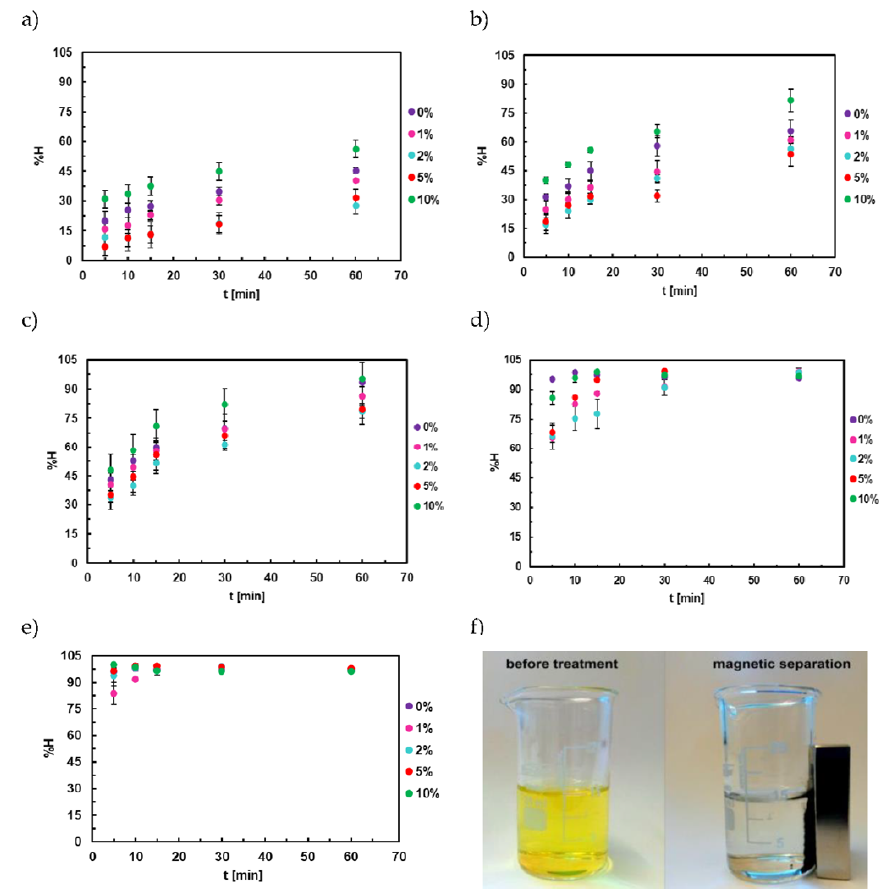
Figure 7. UV-vis adsorption efficiency of Titan yellow dye after ( a ) 10 mg, ( b ) 20 mg, ( c ) 40 mg, ( d ) 100 mg, ( e ) 200 mg nanoparticles addition in function of time, and ( f ) TY solution after treatment and magnetic separation with Fe 3 O 4